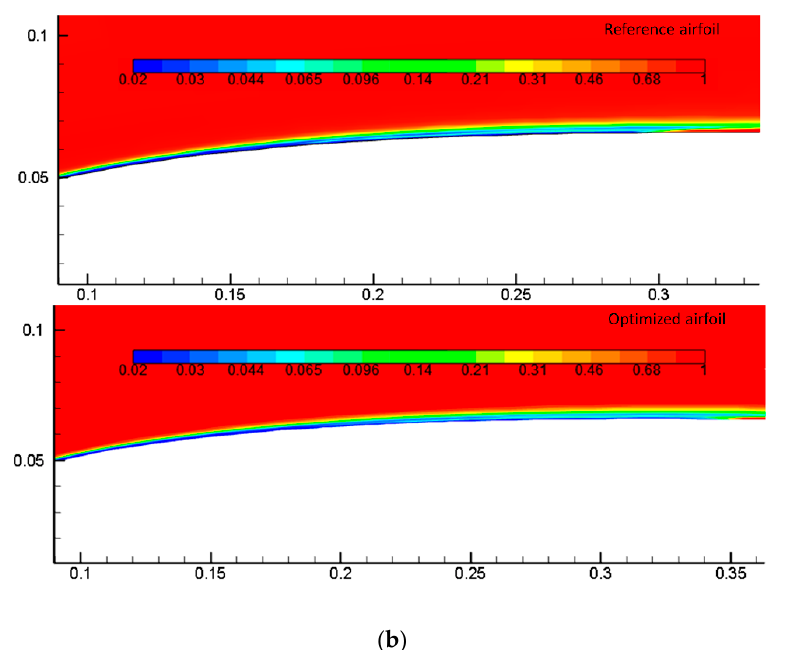
Figure 14. Assessment of the ( a ) velocity contours for the reference and optimized airfoil, and ( b ) intermittency contours the reference and optimized airfoil for drag minimization.